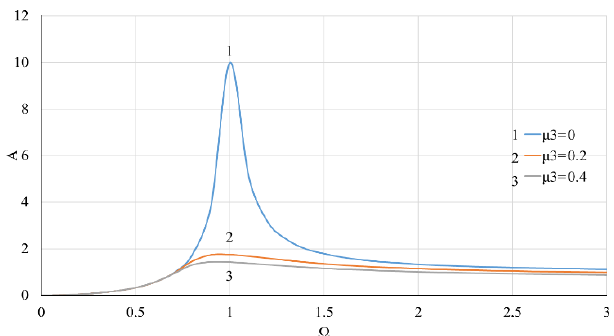
Figure 6. Dependence of the vibration amplitude A on the rotor velocity (cid:127) with linear stiffness of the support and at value of the coefficient of linear viscous damping µ 1 = 0.1 and various values of nonlinear viscous damping coefficient µ 3